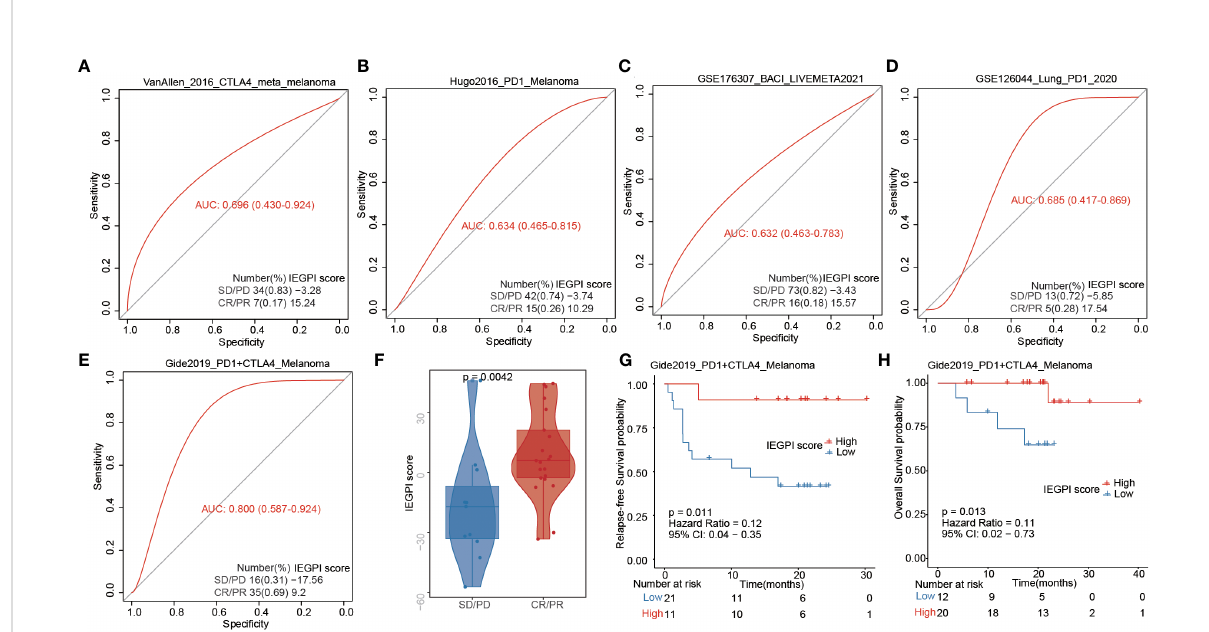
FIGURE 6 IEGPI score for immunotherapy response prediction. (A – E) IEGPI score ’ s potential as a tool for immunotherapy response prediction in melanoma, bladder cancer, and lung cancer; (F) the distribution of IEGPI score in different immunotherapy response groups with both PD-1 and CTLA4 treatment; (G, H) Kaplan-Meier curves of patients with different IEGPI